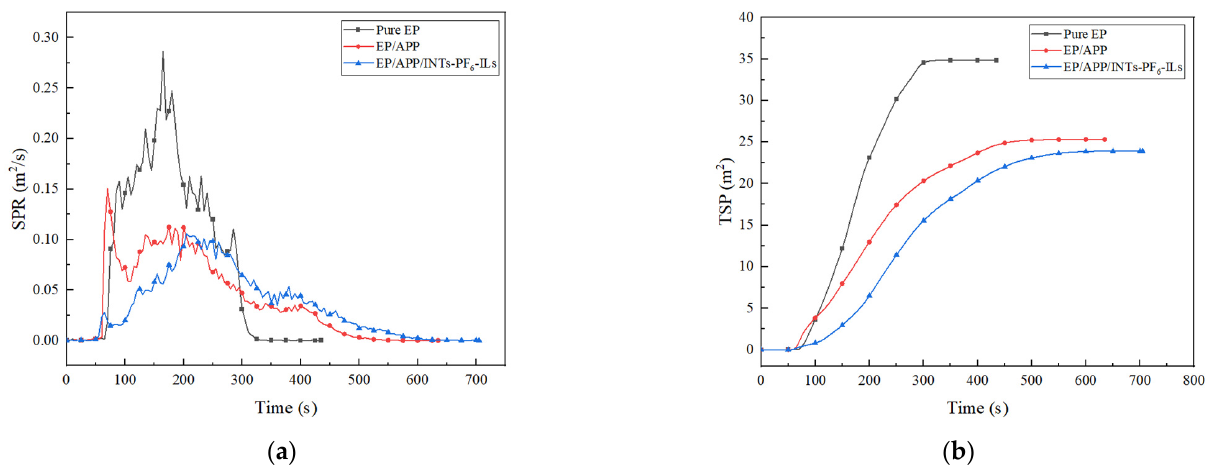
Figure 4. ( a ) SPR curves of EP composites; ( b ) TSP curves of EP composites. The CO yield (Y CO ) and CO 2 yield (Y CO2 ) were also important parameters for evaluat-